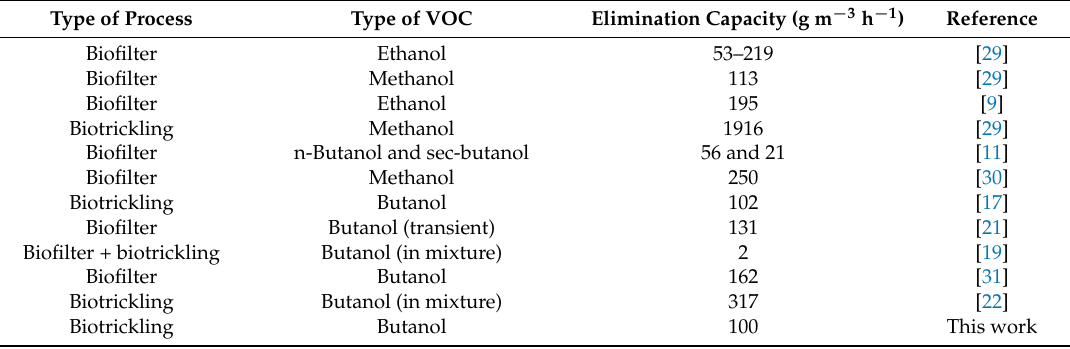
Table 1. Performance comparison between this work and selected other studies on C1 to C4 alcohols using biofilters or biotrickling filters.